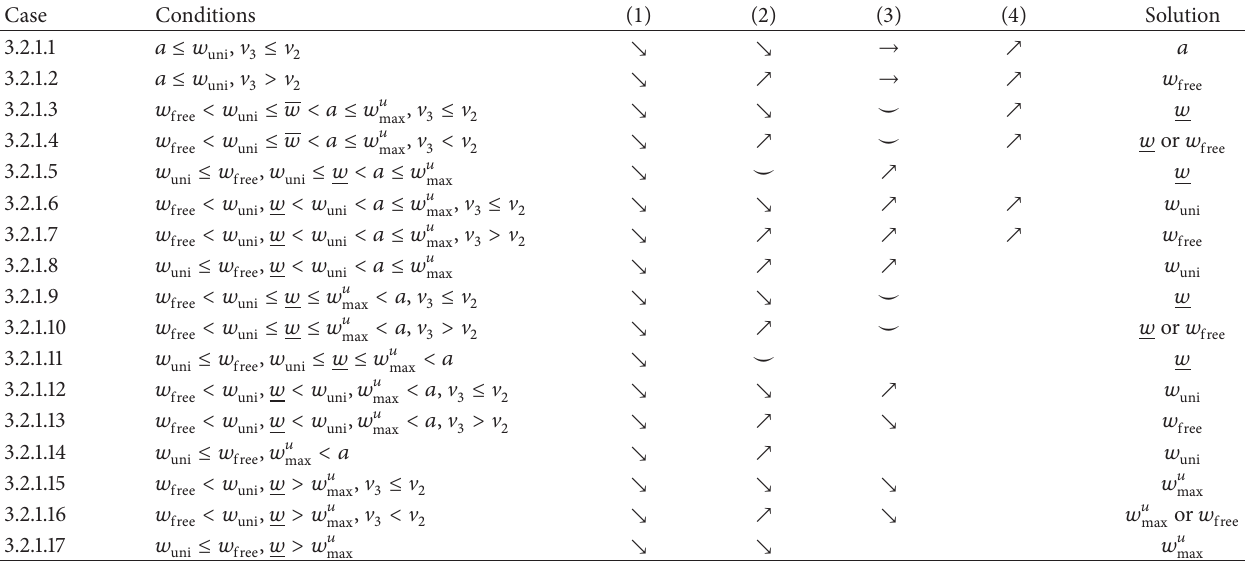
Table 10: Case 3.2.1 .